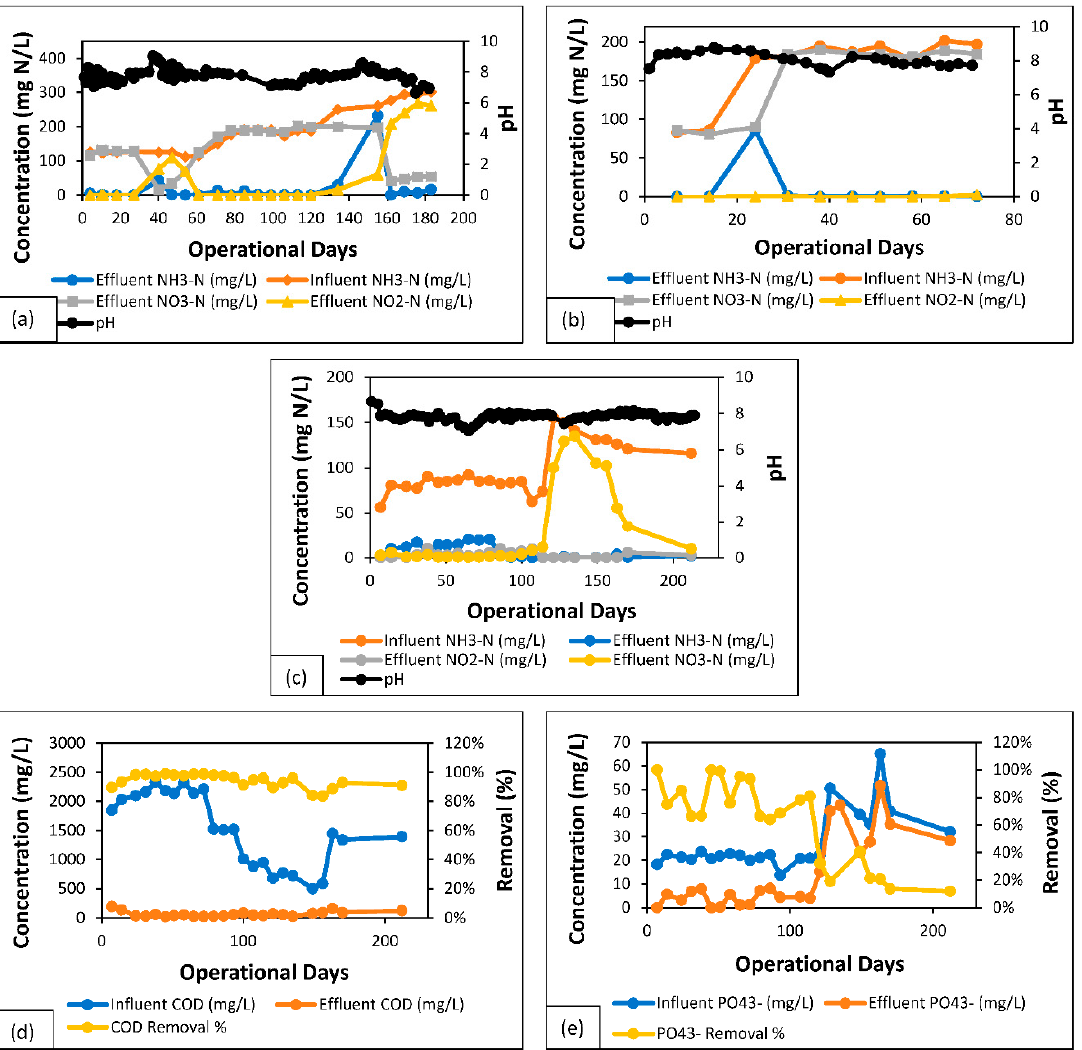
Figure 4. Nitrification profile for ( a ) AGS-SBR-1, ( b ) AGS-SBR-2, and ( c ) AGS-SBR-3; ( d ) COD profile for AGS-SBR-3, and ( e ) Phosphorus (as PO 43 − ) profile for AGS-SBR-3.